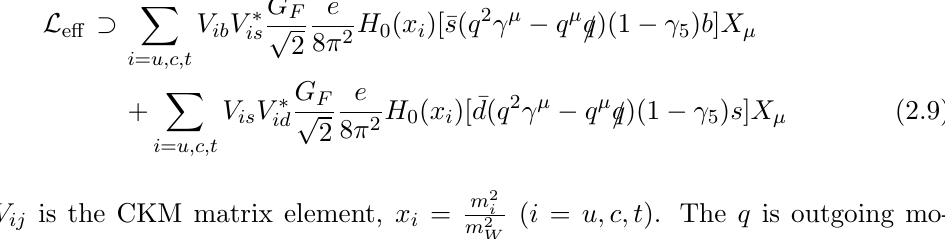
JHEP04(2020)086